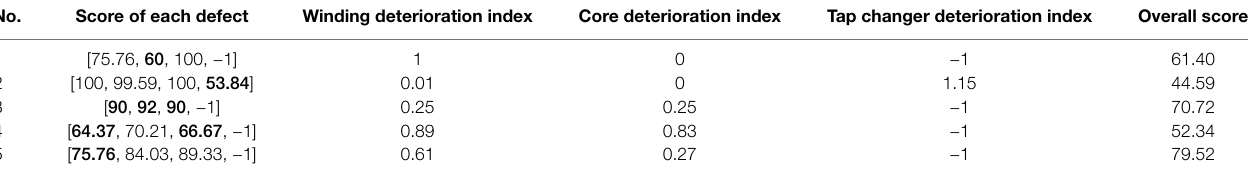
TABLE 8 | Results of the condition assessment and the degree of deterioration of the components.